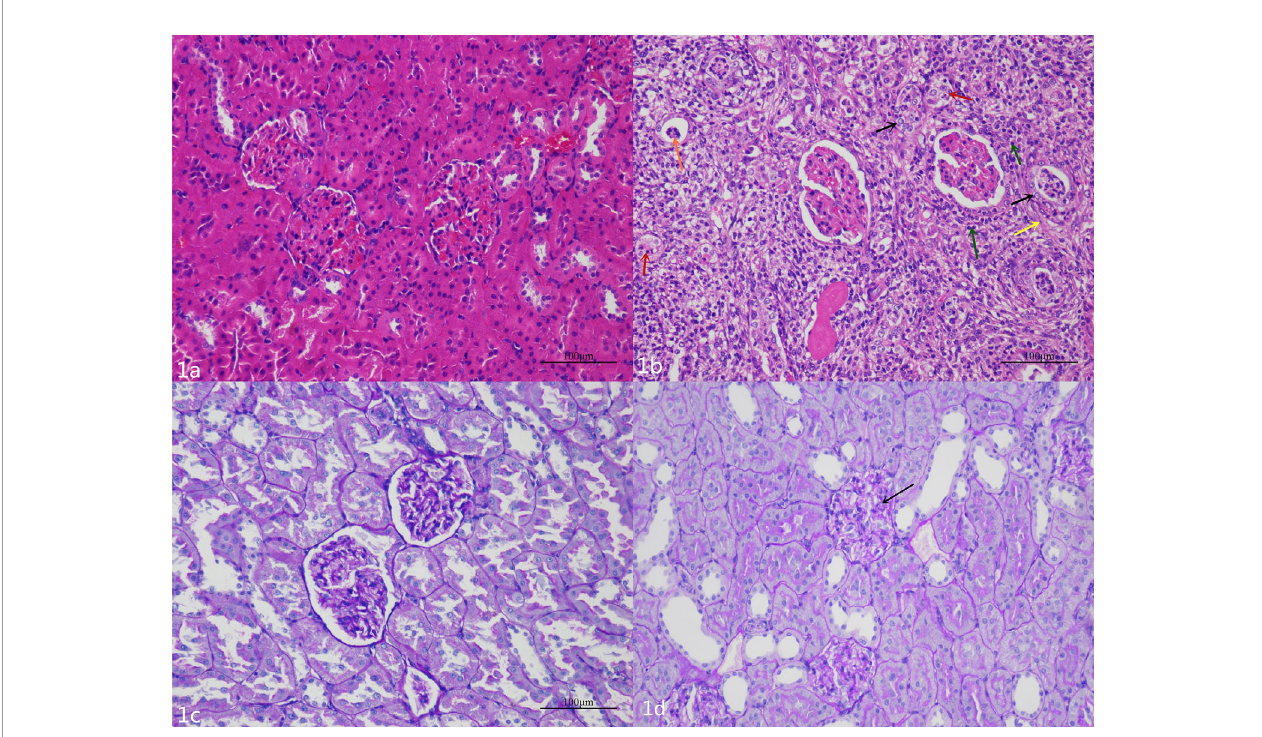
FIGURE 1 | (A) The glomeruli and tubules of the NC group are normal. (B) Hematoxylin and eosin staining shows that there are different degrees of renal pathological injury in the DN rats. The structure of the renal tissue is disordered, the renal tubular structure was not clear, a large number of renal tubular epithelial cells are swollen, and the cytoplasm is loose (black arrow); a small number of renal tubular epithelial cells are necrotic, and the nucleus is deeply stained or fragmented (red arrows).The renal tubular interstitial connective tissue is hyperplasic (yellow arrow) and accompanied by a small amount of in fl ammatory cell in fi ltration (green arrows); necrotic cell fragments can be seen in some renal tubules (orange arrow). (C) The renal basement membrane in the NC group is normal. (D) The basement membrane is slightly thickened and wrinkled (black arrow), and the mesangial cell is mildly hyperplasic in the DN